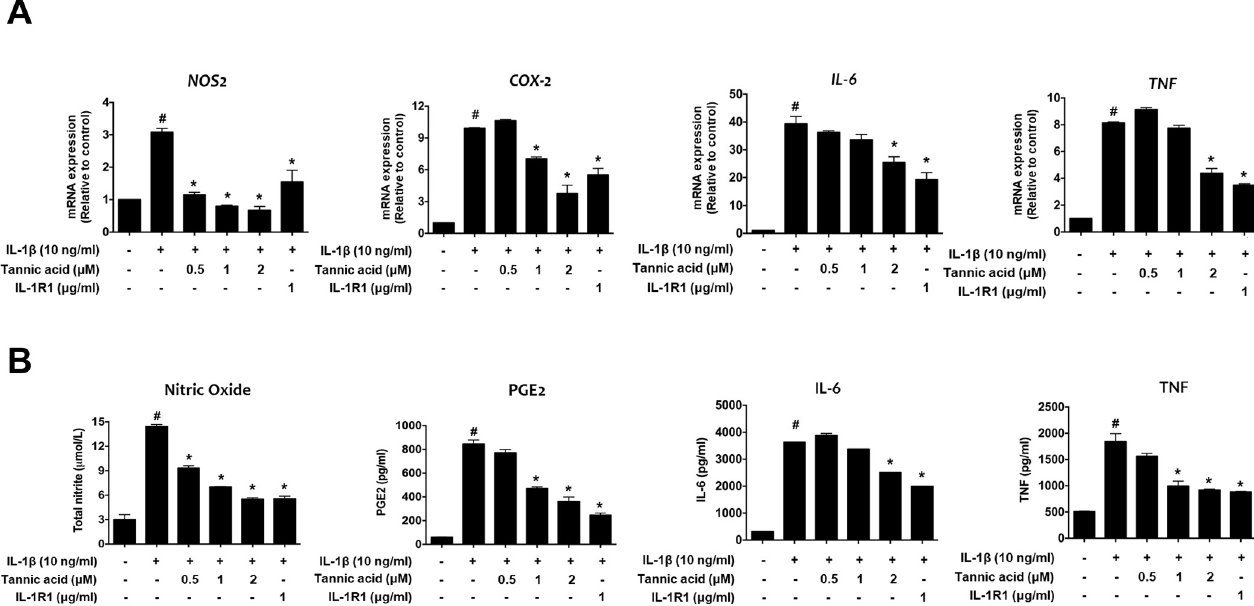
Fig 2. Effects of TA on the levels of inflammatory mediators in IL-1 β -stimulated human OA chondrocytes. Human articular chondrocytes from OA patients were seeded onto 12-well plates (2 × 10 5 cells/well) and serum-starved cells were co-treated with various concentrations of TA (0.5, 1, or 2 μ M) or IL- 1R1 (1 μ g/ml) and IL-1 β (10 ng/ml) for 48 h. (A) The mRNA expression levels of iNOS , COX-2 , IL-6 , and TNF were measured using qRT-PCR. The relative quantity of each gene expression was normalized to the relative quantity of human GADPH. (B) Griess reaction was used to measure the NO levels in the culture supernatants and PGE2, IL-6, and TNF levels in the culture supernatants were evaluated using ELISA. # p < 0.05 compared with medium only control group and * p < 0.05 compared with IL-1 β -treated group.